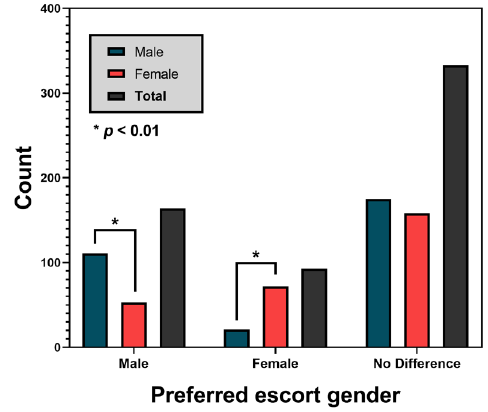
Figure 3. Escort Preferences Based on